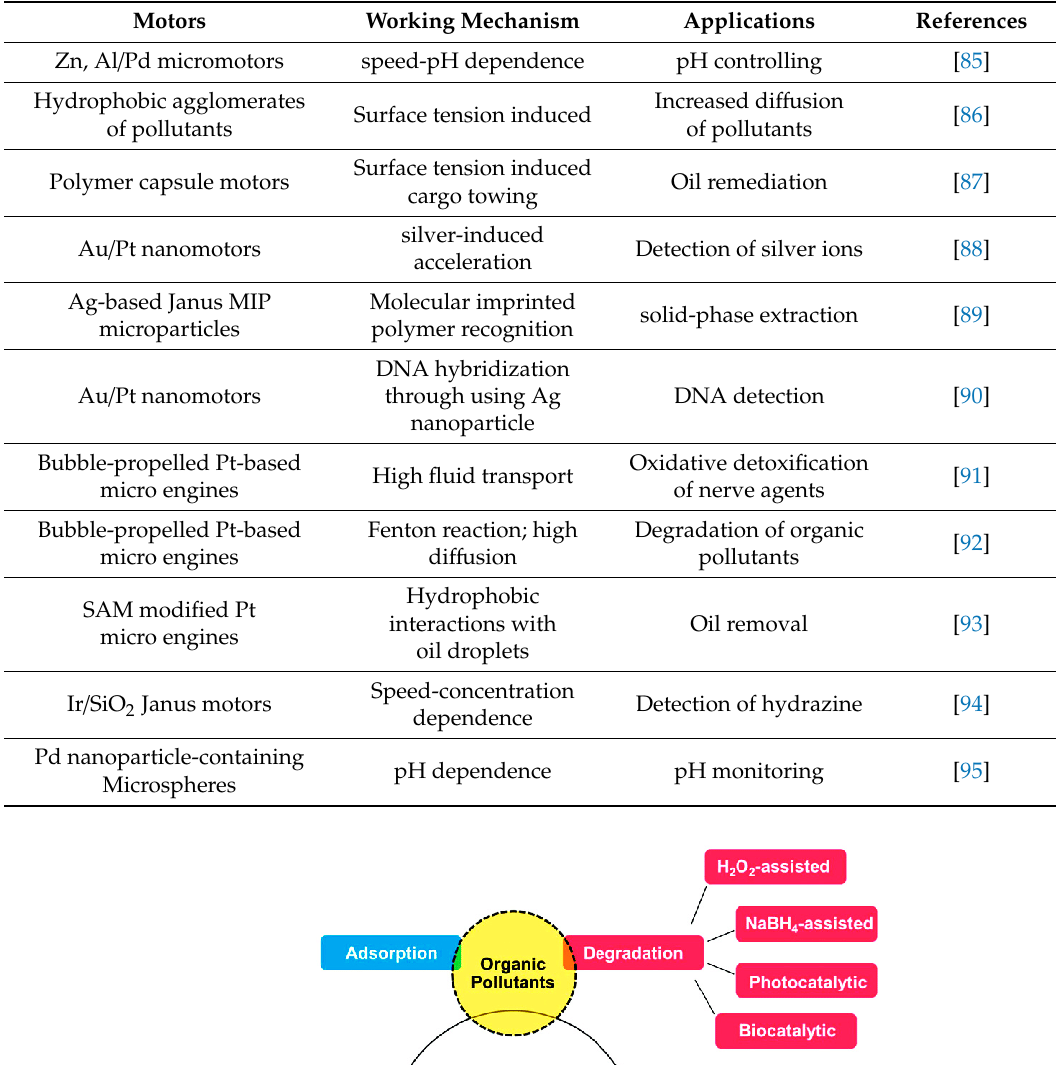
Figure 3. Different degradation and mineralization products of Lignocaine.